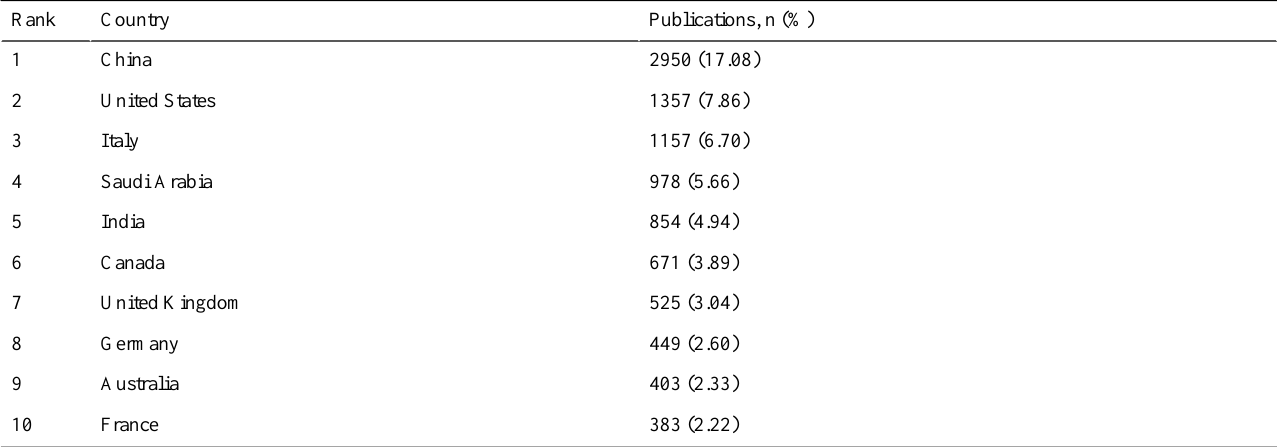
Table 1. Top 10 countries (N=221) by the number of COVID-19–related publications